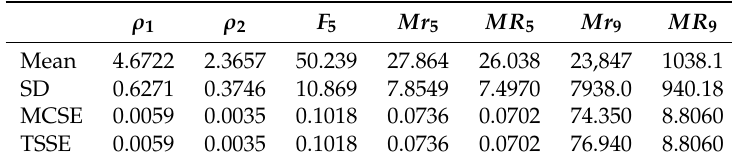
Table 2. Summary statistics for the posterior distribution of ρ 1 , ρ 2 , F 5 , Mr 5 , MR 5 , Mr 9 , and MR 9 , given FM 4 . SD: standard deviation; MCSE: Monte Carlo standard error; TSSE: time-series standard error.